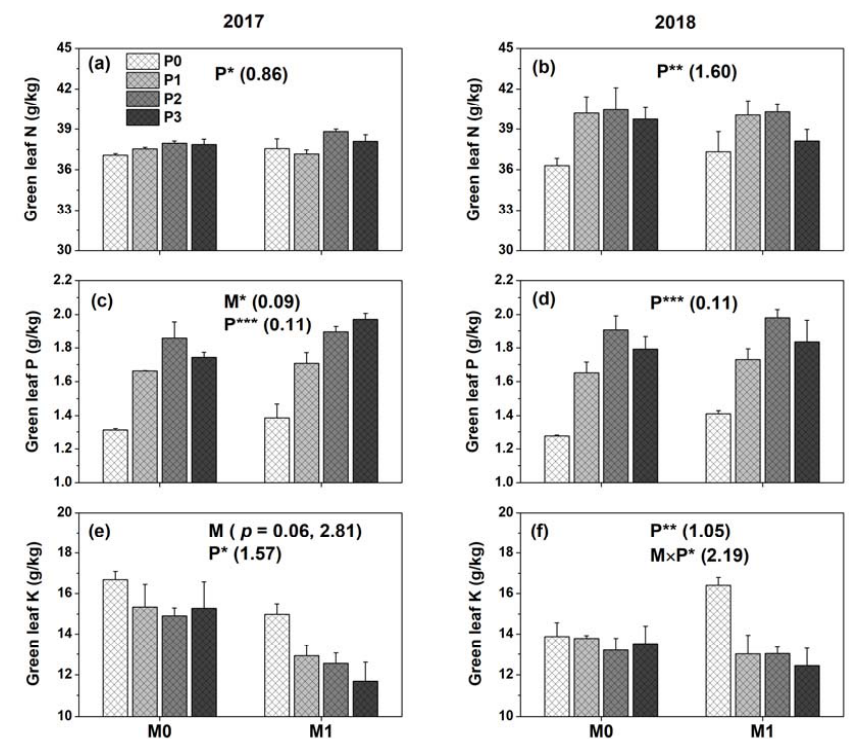
Figure 2. E ff ect of film mulch (M) and P fertilization (P) on concentrations in green leaves of ( a , b ) N, ( c , d ) P, and ( e , f ) K in 2017 and 2018. M0P0, M0P1, M0P2, M0P3, M1P0, M1P1, M1P2, and M1P3 represent no mulch (M0) and mulch (M1) with four levels of P (P0, P1, P2, and P3), respectively. ***, p ≤ 0.001; **, p ≤ 0.01; *, p ≤ 0.05. Numbers in parentheses are LSD values among treatments ( p = 0.05). Error bars show one standard error of the mean.